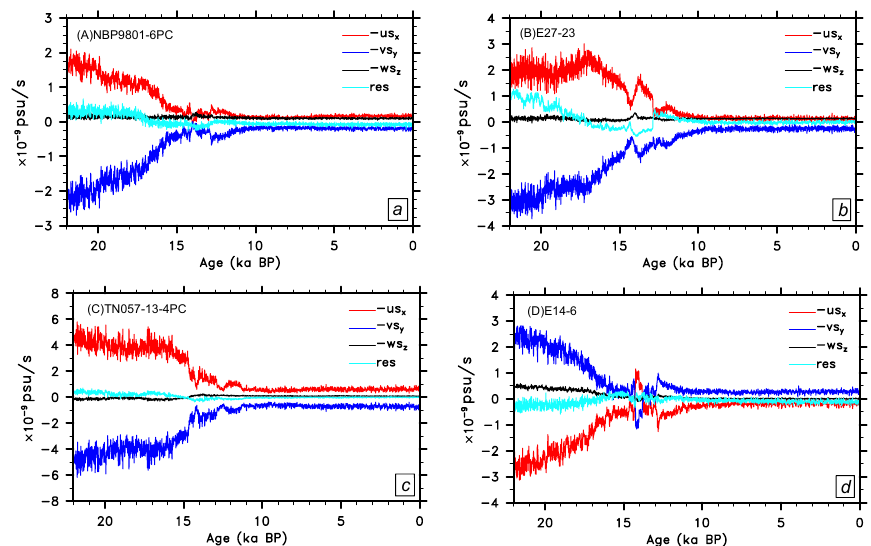
Figure 8. The vertical integrated salinity budget below 200 m at proxy cores ( a – d ) during the last 22,000 years, which is composed of zonal salinity advection ( − us x , red), meridional salinity advection ( − vs y , blue), vertical salinity advection ( − ws z , black) and residual ( res , cyan) terms.